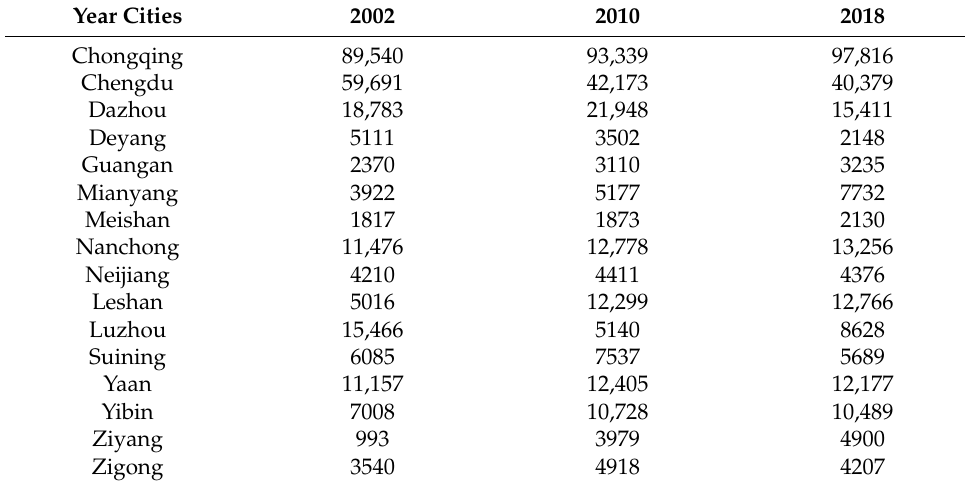
Figure 6. Radiation sphere of the CCUA. Table 4. Radiation spheres for CCUA cities (unit: km 2